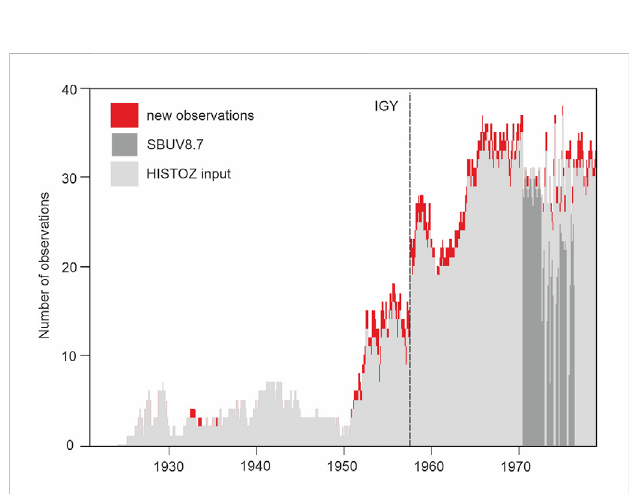
FIGURE 2 Number of historical monthly means assimilated from 1924 to